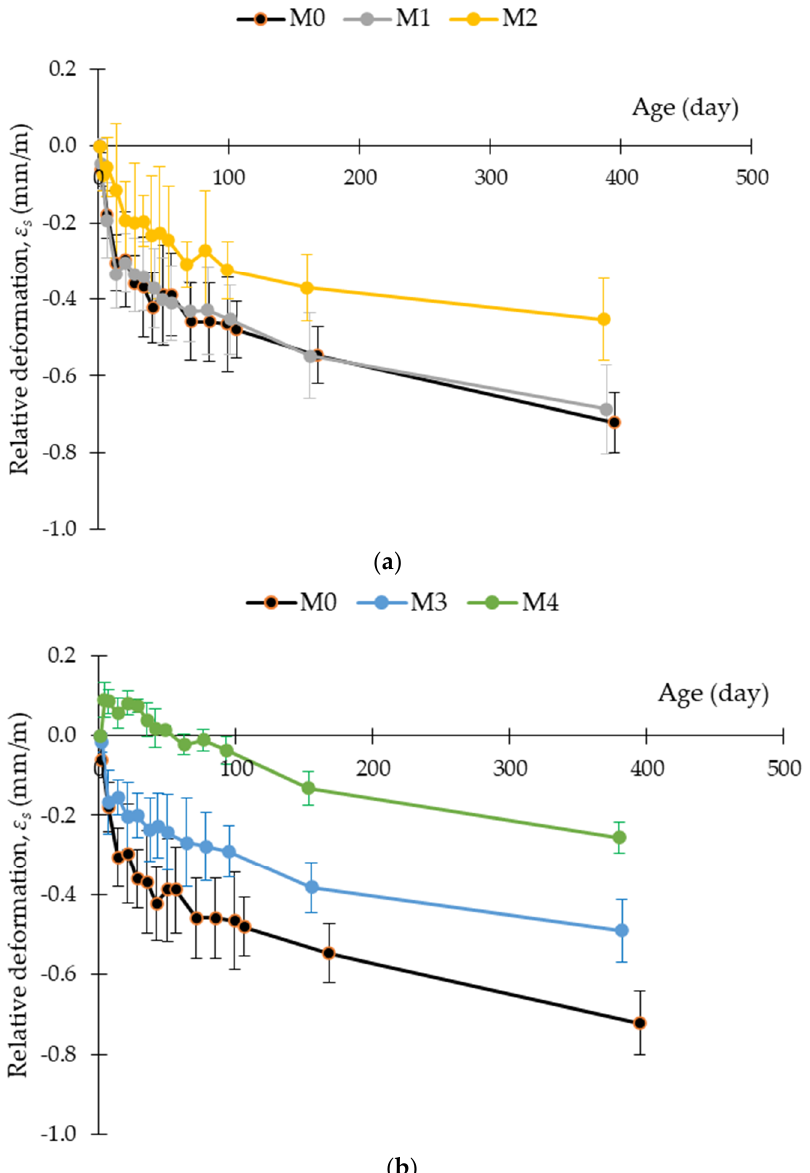
Figure 6. Results of the length change measurements: ( a ) Mixes M0, M1, and M2; ( b ) Mixes M0, M3, and M4.